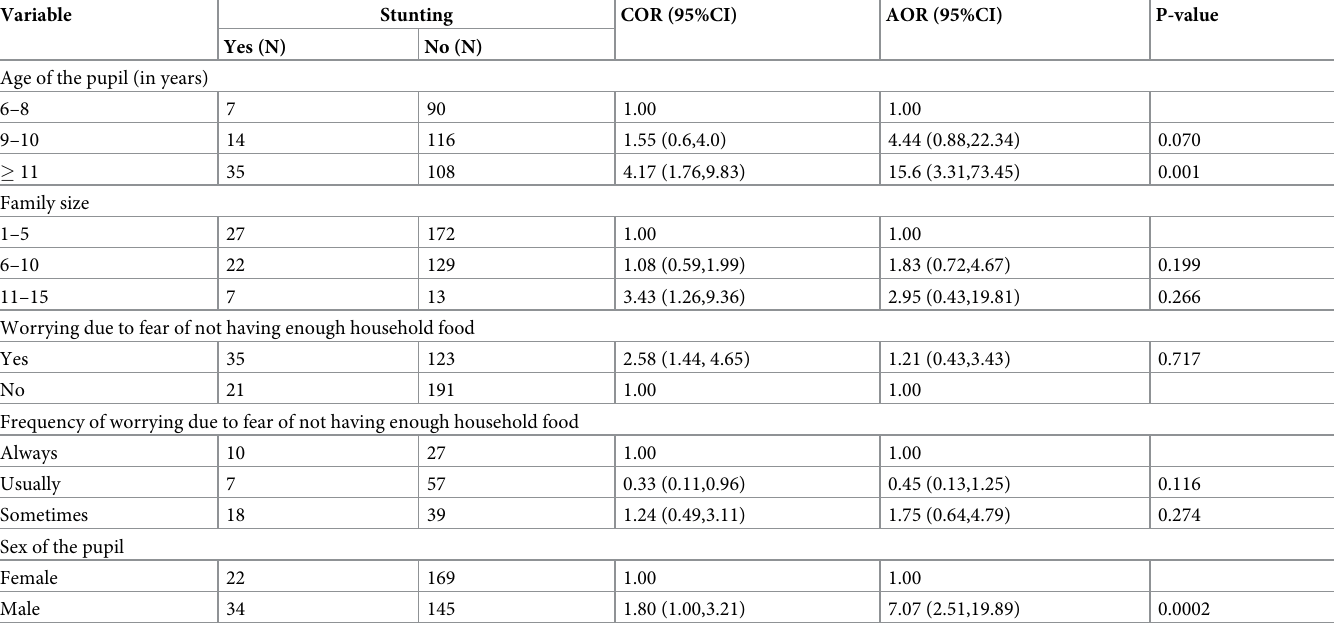
Table 3. Simple logistic regression analysis on factors associated with stunting among Bahir Dar city public primary school pupils, North West Ethiopia, 2109.